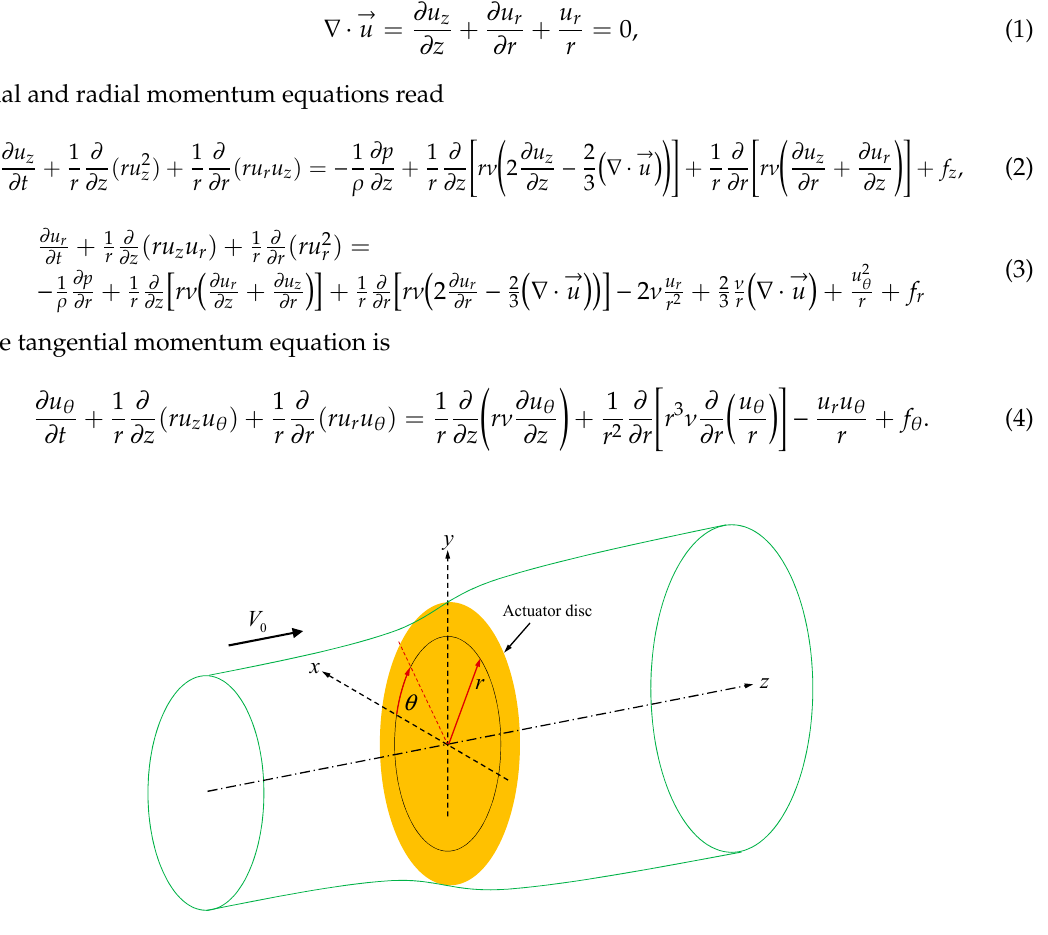
Figure 1. Definition of coordinates and the stream tube through an actuator disc.